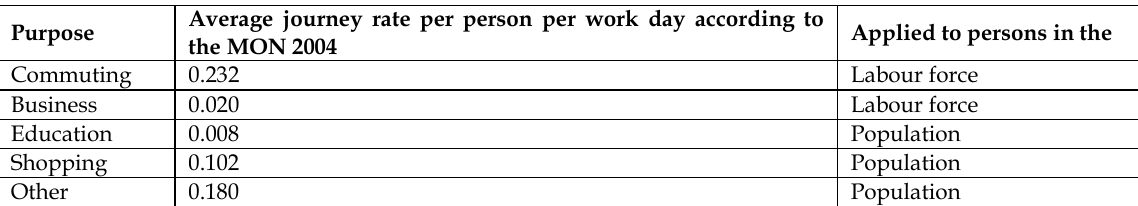
Table 1. Travel purpose-dependent differentiation in journey rates